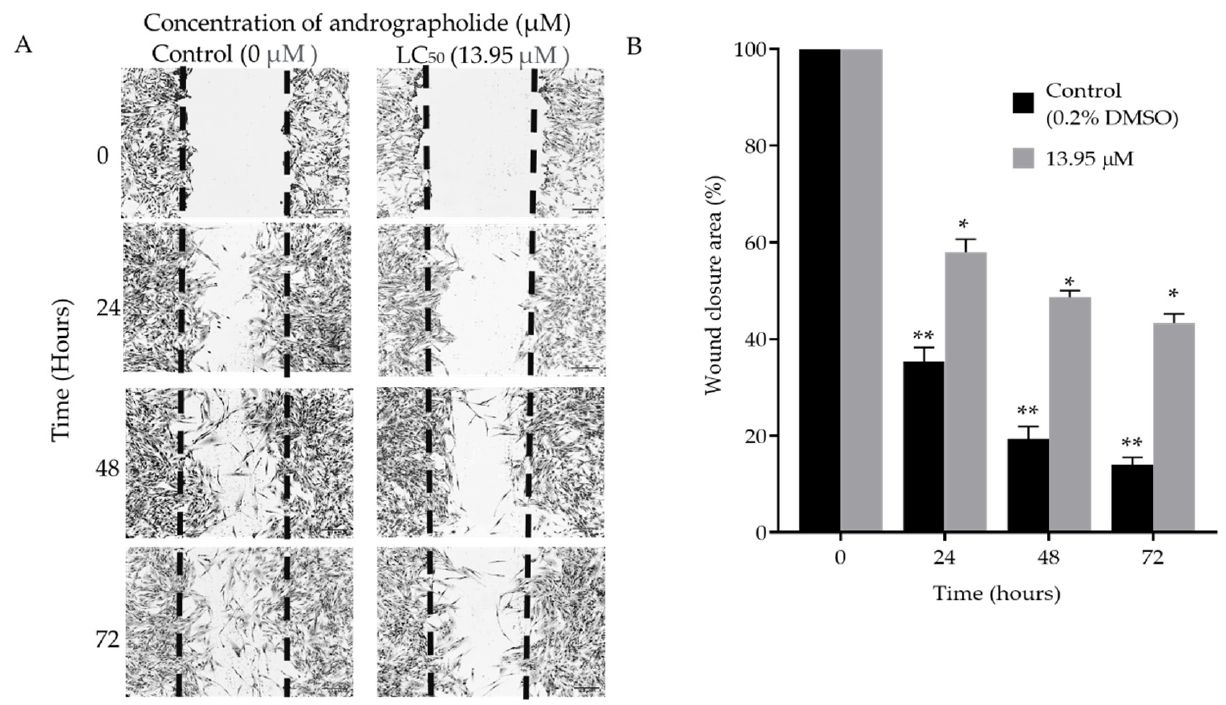
Figure 2. The effect of andrographolide in reducing migration of DBTRG-05MG cell lines. ( A ) The closure of the wound-healing area after 24, 48, and 72 h of DBTRG-05MG cell line treated with 13.95 µ M andrographolide and without andrographolide as the control. ( B ) The % comparison of wound closure area of DBTRG-05MG cell lines when treated and untreated with andrographolide at 0, 24, 48, and 72 h. Data expressed as mean ± SEM and statistical analysis between three independent groups were performed by multiple t-tests compared with the control group (* p < 0.005, ** p < 0.0005).